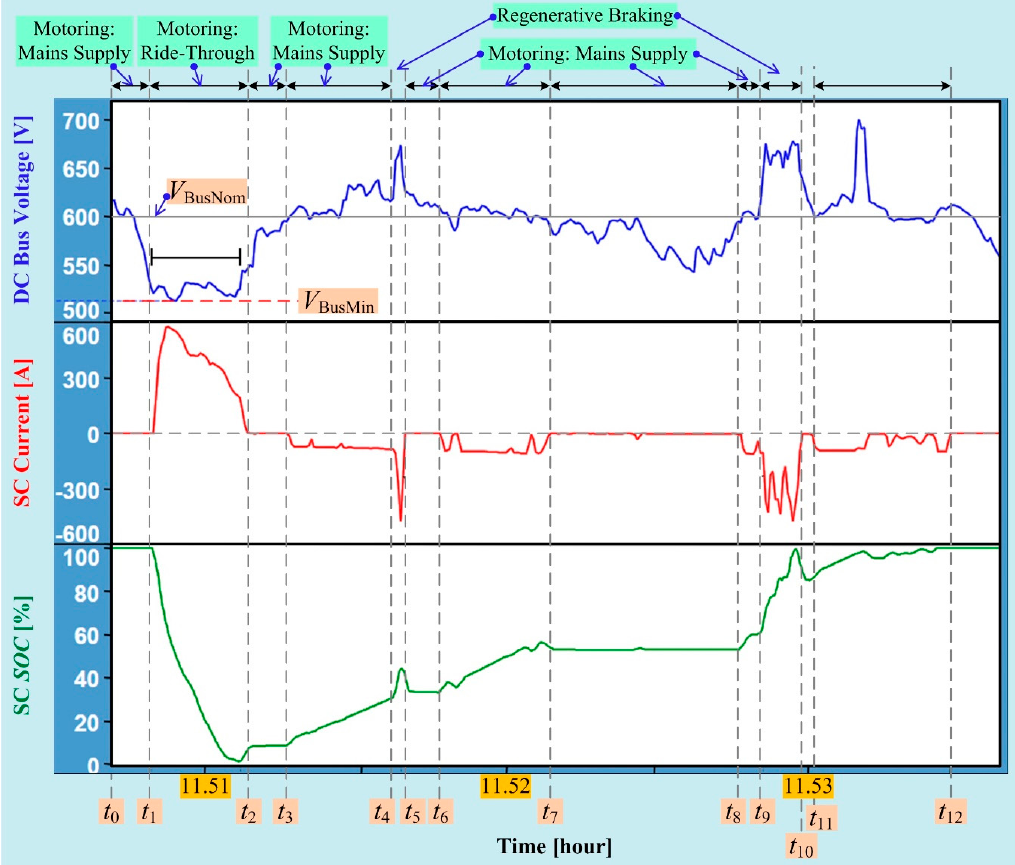
Figure 6. Metro drive cycle behaviors based on a SC energy storage substation, adapted from Godbersen [16]. Godbersen